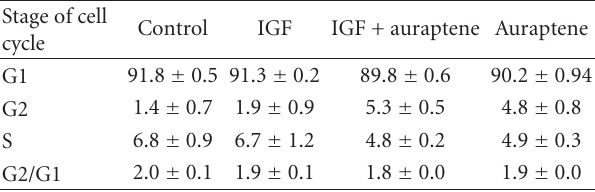
Table 1: Average percentage of cells at 8h time point. Stage of cell